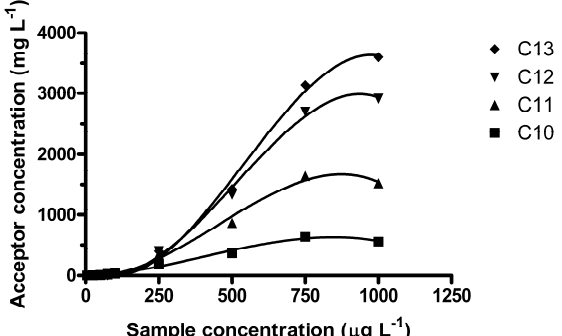
Figure 3. Acceptor concentration as a function of sample concentration over a wide LAS concentration range ( n = 3). Conditions as Figure 1, except 100 mL sample extracted during 20 h at 550